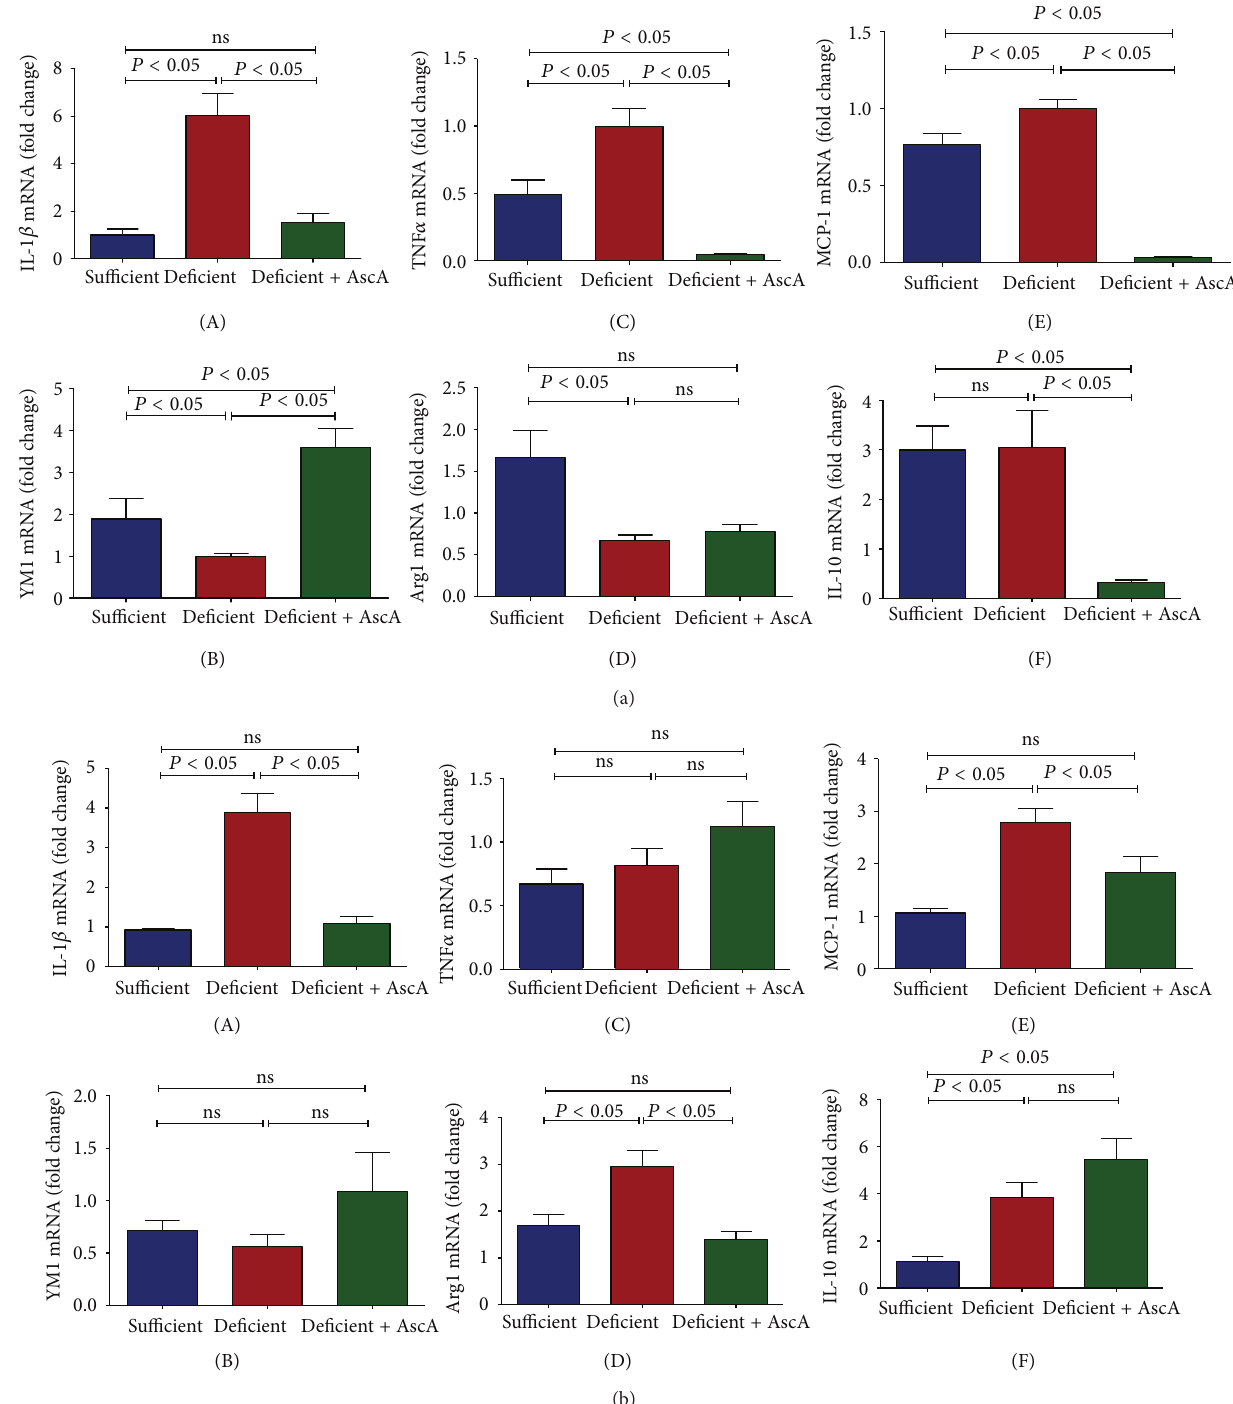
Figure 2: Spatiotemporal profiling of inflammatory mediators following TG-induced peritoneal inflammation. Real time QPCR for IL-1 𝛽 , TNF 𝛼 , MCP-1, YM1, Arg1, and IL-10 mRNA from peritoneal macrophages elicited on day 3 (a) and day 5 (b) following TG-induced peritonitis from VitC sufficient and deficient Gulo −/− mice. Following TG challenge, some VitC deficient mice were randomized to receive daily i.p. injection of VitC as AscA (200 mg/kg in saline) for a further 3 days (day 3, deficient + AscA) or 5 days (day 5, deficient + AscA) ( 𝑁 = 6 mice/group, ns = not